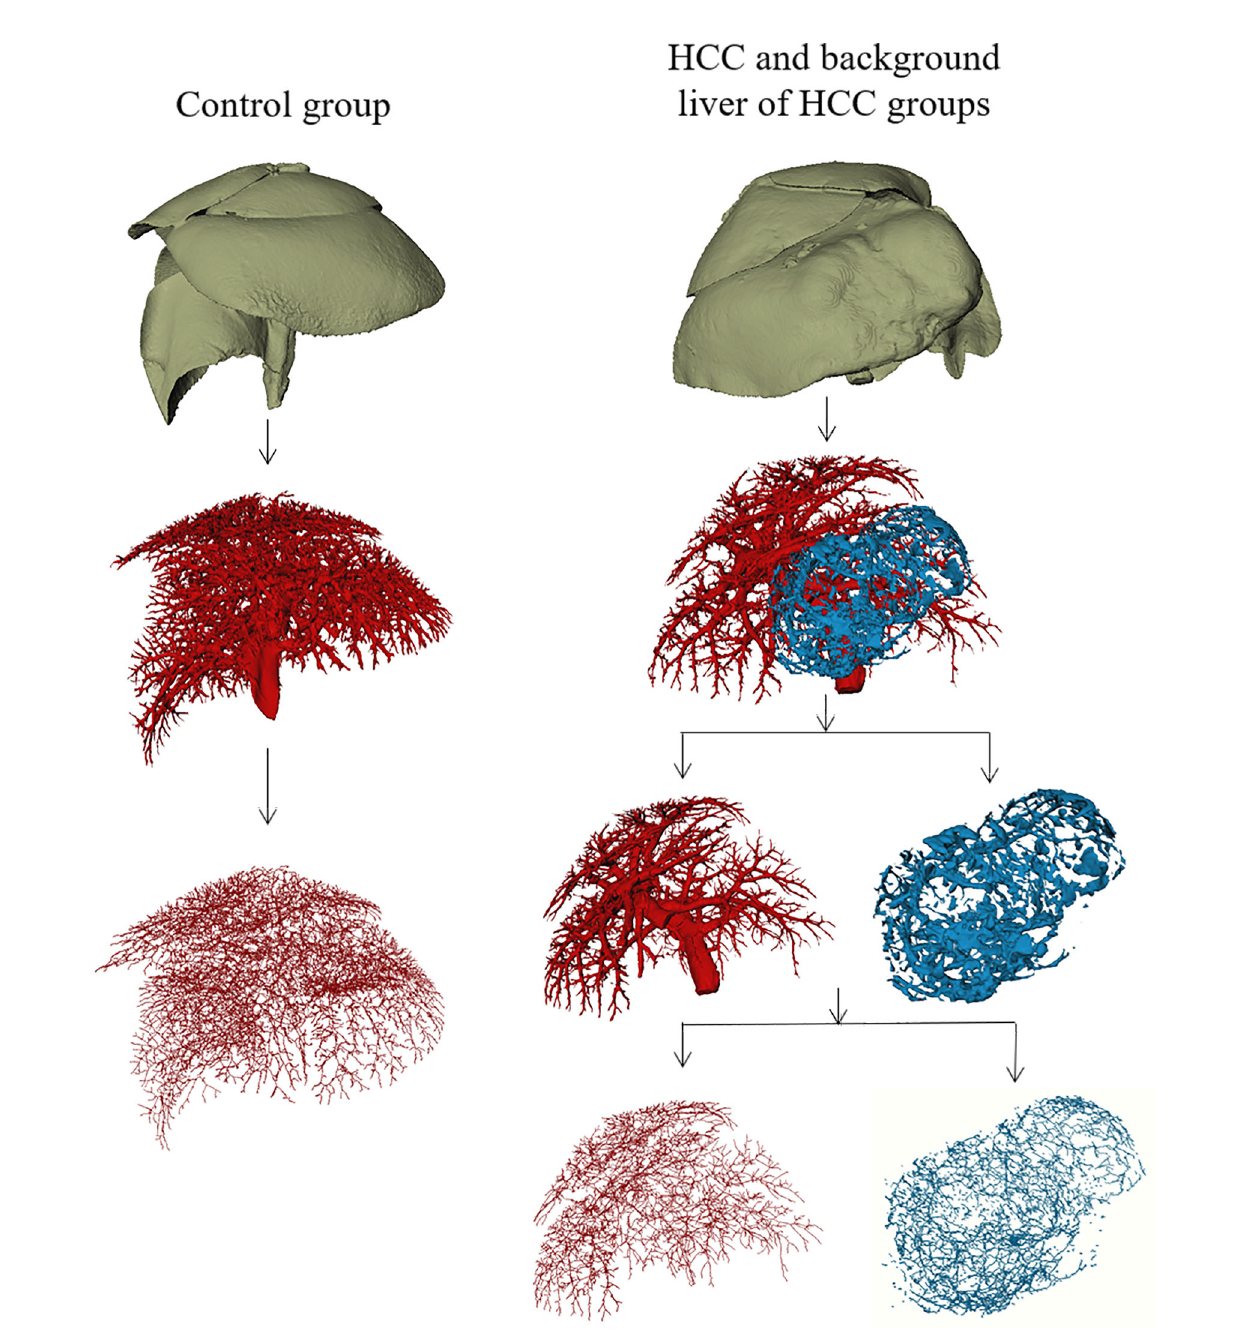
FIGURE 2 | Macroscopic 3D reconstructions and centerlines of the control group, the tumor region of HCC group, and background liver of HCC